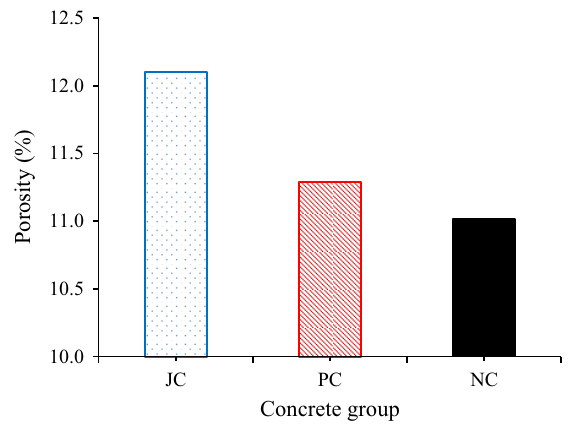
Figure 9: Porosity of the three concretes at 28